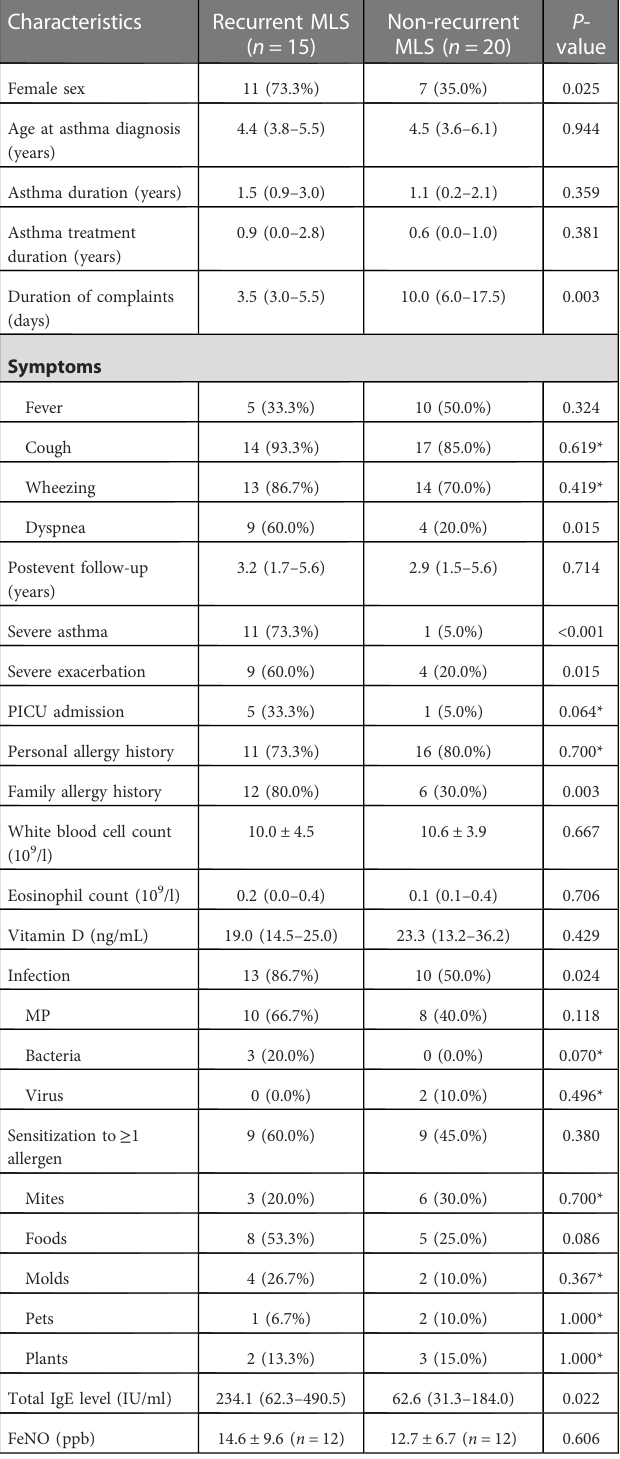
TABLE 1 Clinical features of asthmatic children with RML and/or lingula atelectasis strati fi ed by recurrent MLS.